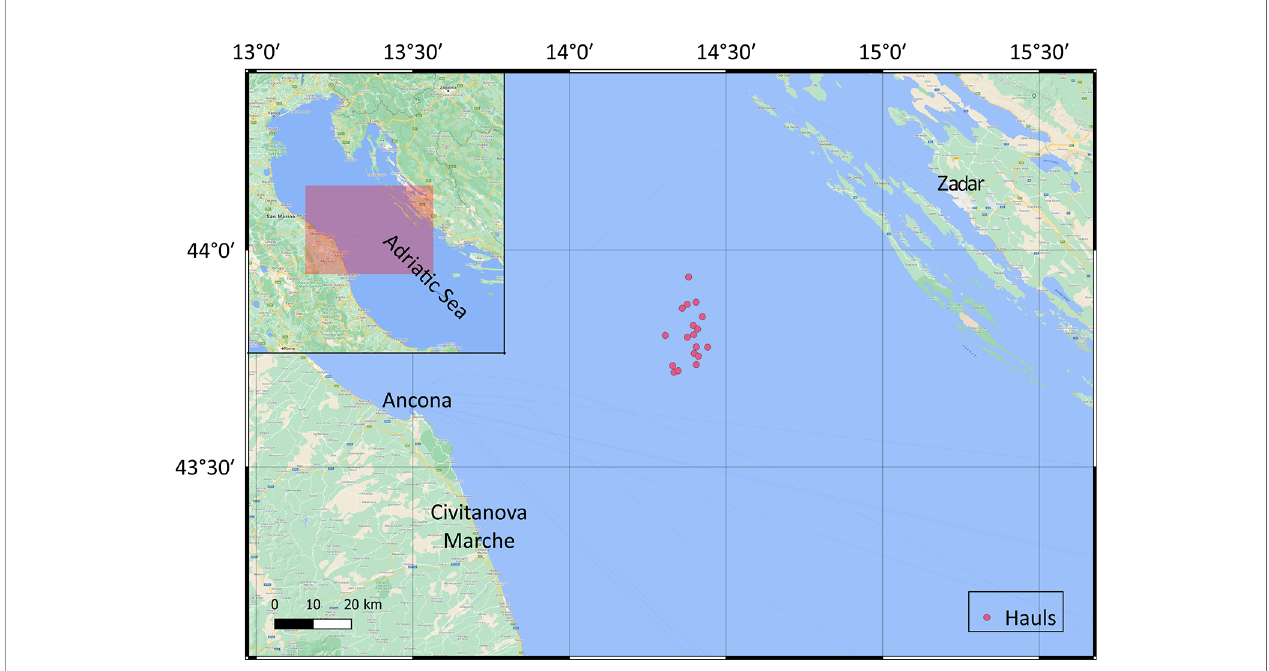
FIGURE 2 | Map of the area where the hauls were carried out.